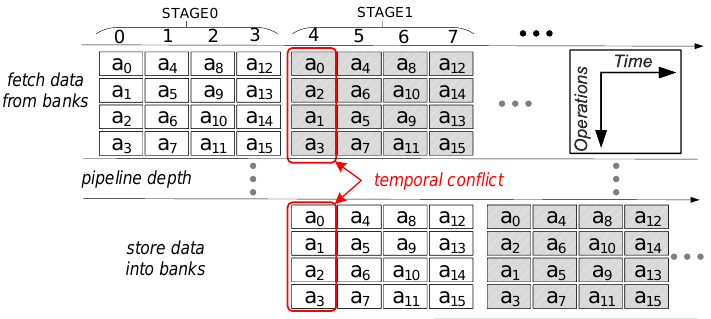
Figure 1: The temporal conflict in pipelined in-place NTT